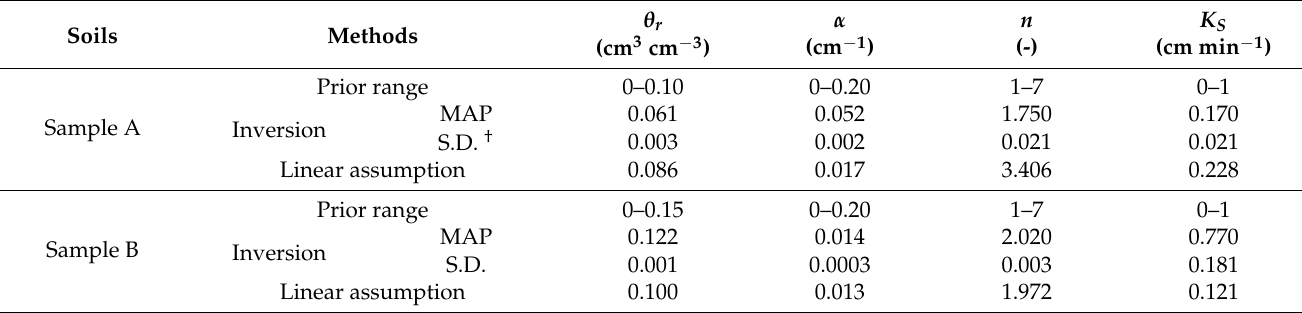
Figure 8. Marginal posterior probability density functions of inversion parameters for the real evaporation experiments: ( a – d ) sample A and ( e – h ) sample B. Table 3. Soil hydraulic parameters of samples A and B that were obtained when using the SO inversion approach and the linear